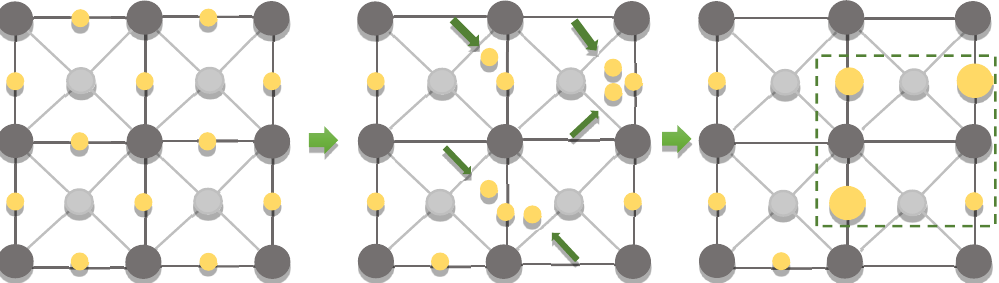
Figure 23. Schematic representation of the Frenkel defect.